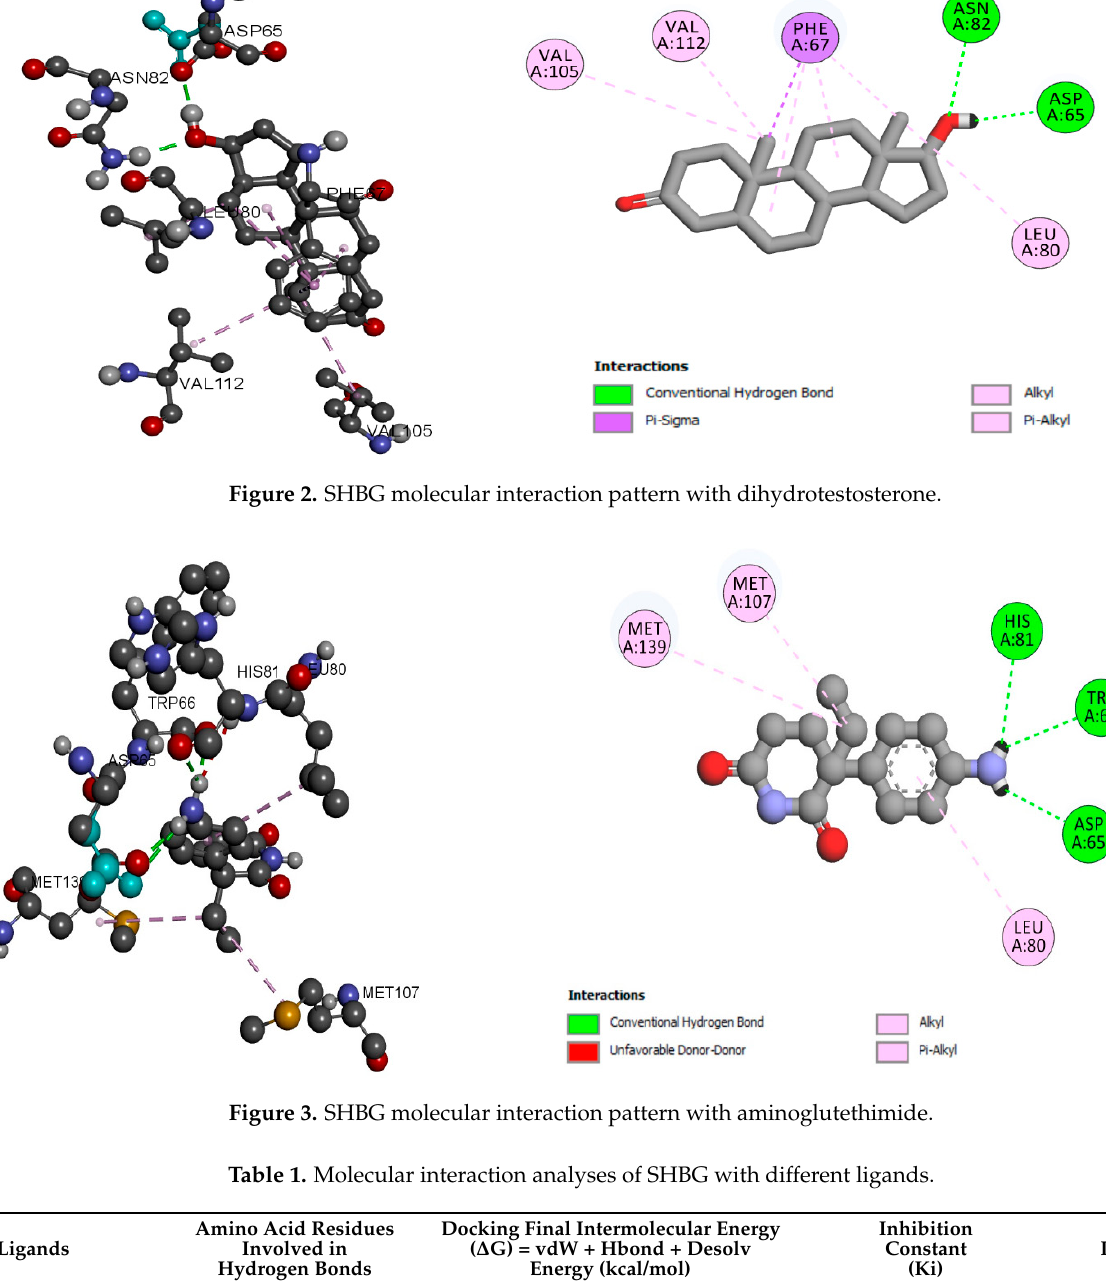
Figure 2. SHBG molecular interaction pattern with dihydrotestosterone.